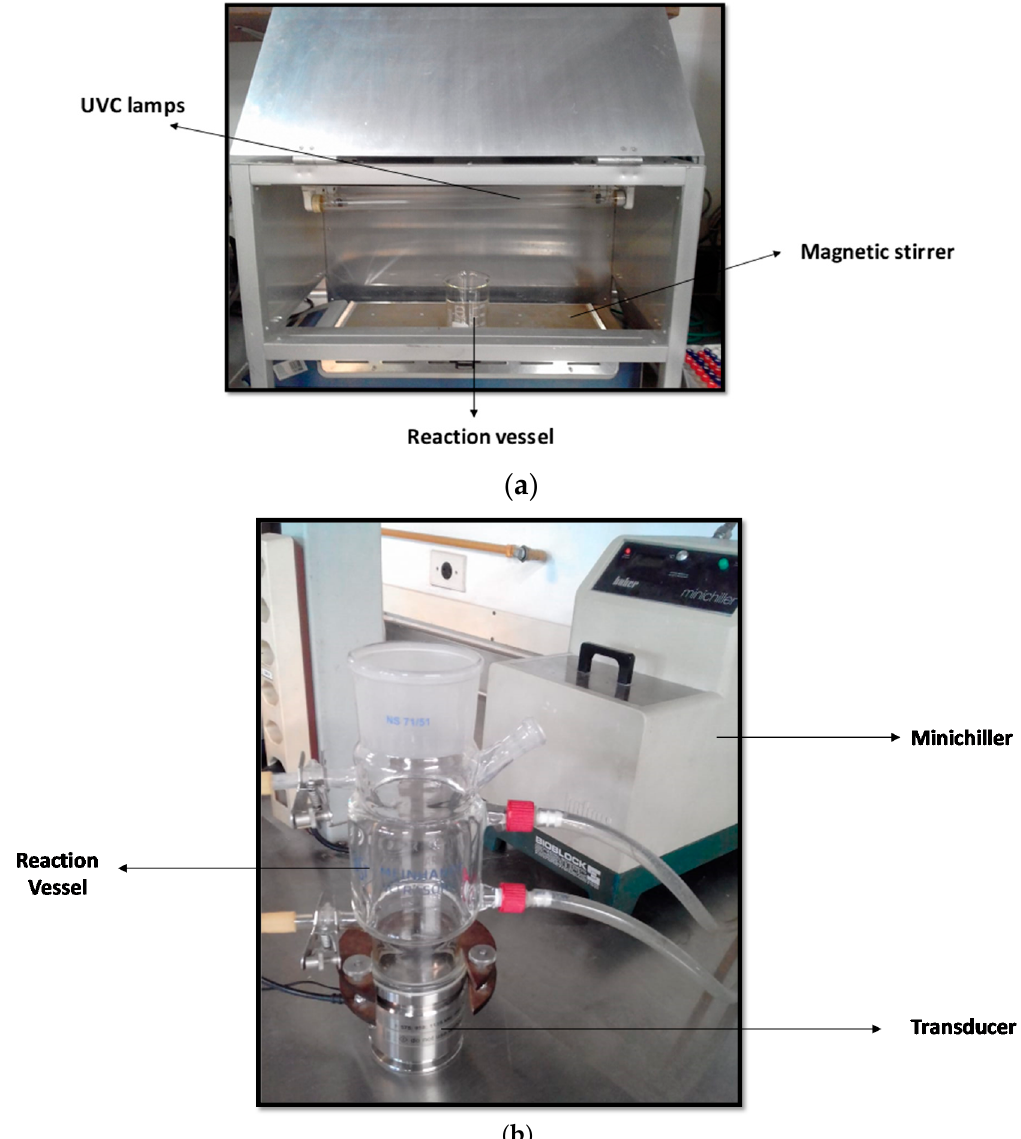
7.0 mL were taken from the reaction systems, and for the TOC analyses, the experiments were carried out independently from the initial tests of degradation (to avoid retire amounts higher than 10% of the initial volume in each system).